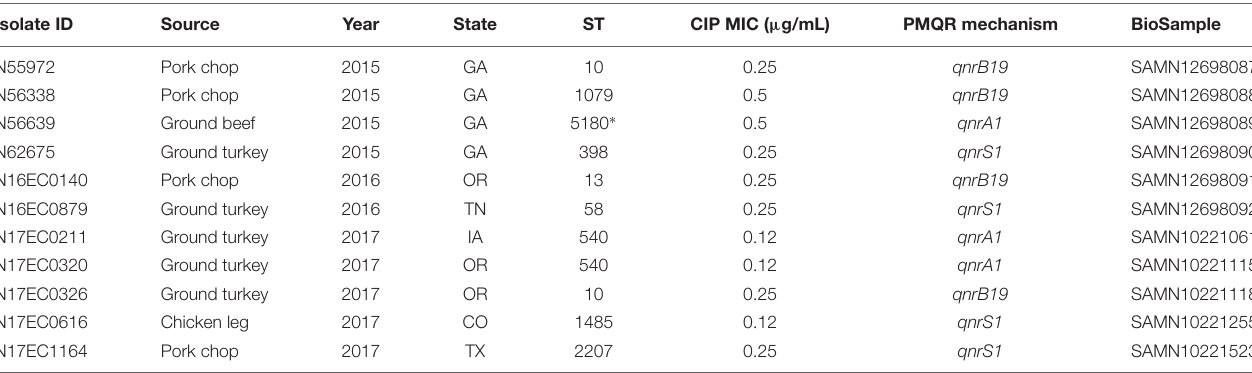
TABLE 1 | Metadata for isolates with PMQR genes.